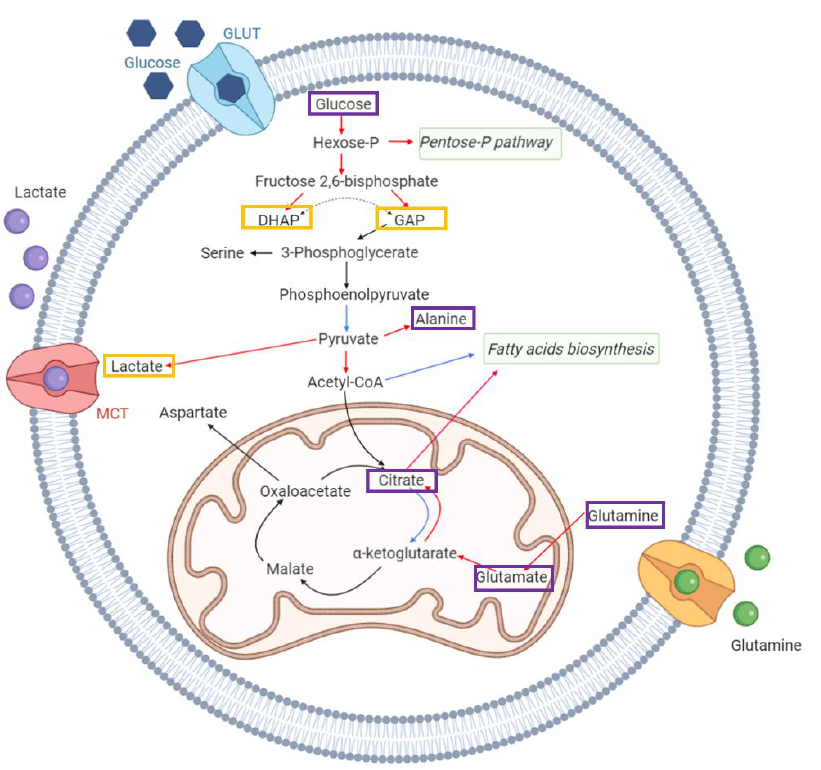
Figure 5. Metabolic representation of Warburg-related modifications in a typical bladder cell which could explain the metabolic perturbations observed in the analyzed serum samples. Blu lines represent reactions generally slower in cancer cells, while red lines reaction generally faster. Orange squares indicated metabolite increased in our bladder cancer cohort, while purple squares indicated metabolites showing lower concentrations in bladder cancer patients. Abbreviations: GLUT = Glucose Transporter; MCT = Monocarboxylate transporter; DHAP = Dihydroxyacetone phosphate; GAP =